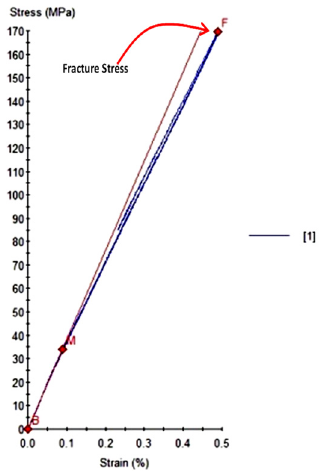
Figure 5. The stress–strain relationship of normal bamboo reinforcement.